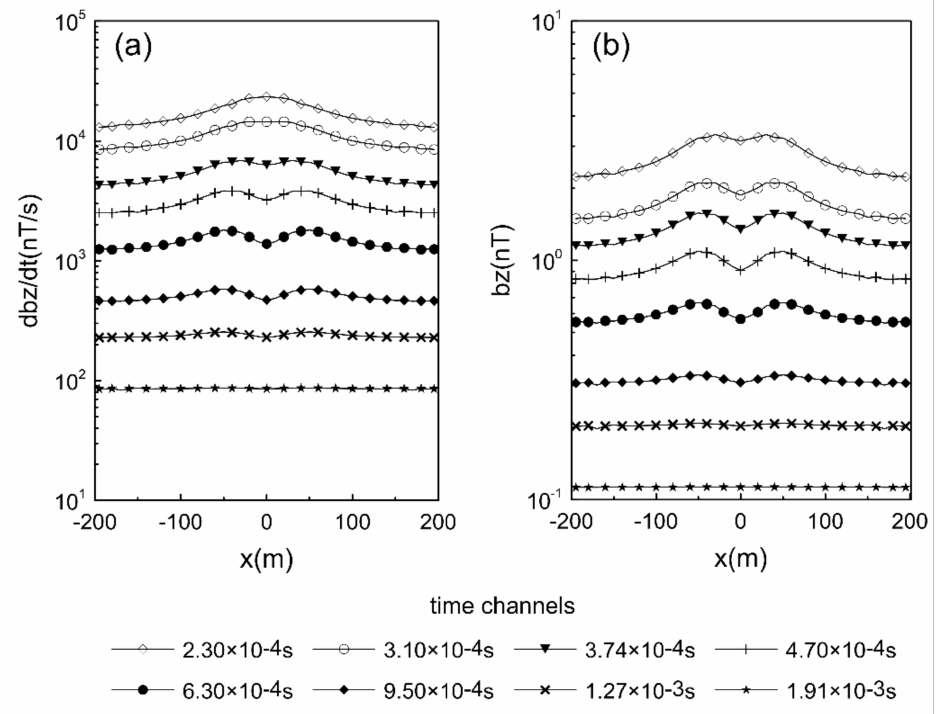
Figure 8. ( a ) dbz/dt and ( b ) bz responses for the vertical dyke model in Figure